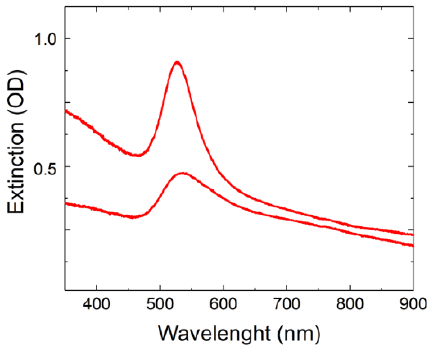
Figure 2. UV–Vis characterization of AuNPs synthesized by Pulsed Laser Ablation in Liquids (PLAL). Two independent batches were analyzed: AuNP-1 (top) with plasmon peak at 523 nm, and AuNP-2 (bottom), with plasmon peak centered at 535 nm, optical density (OD). The extinction spectra are compatible with spherical-shaped AuNPs.